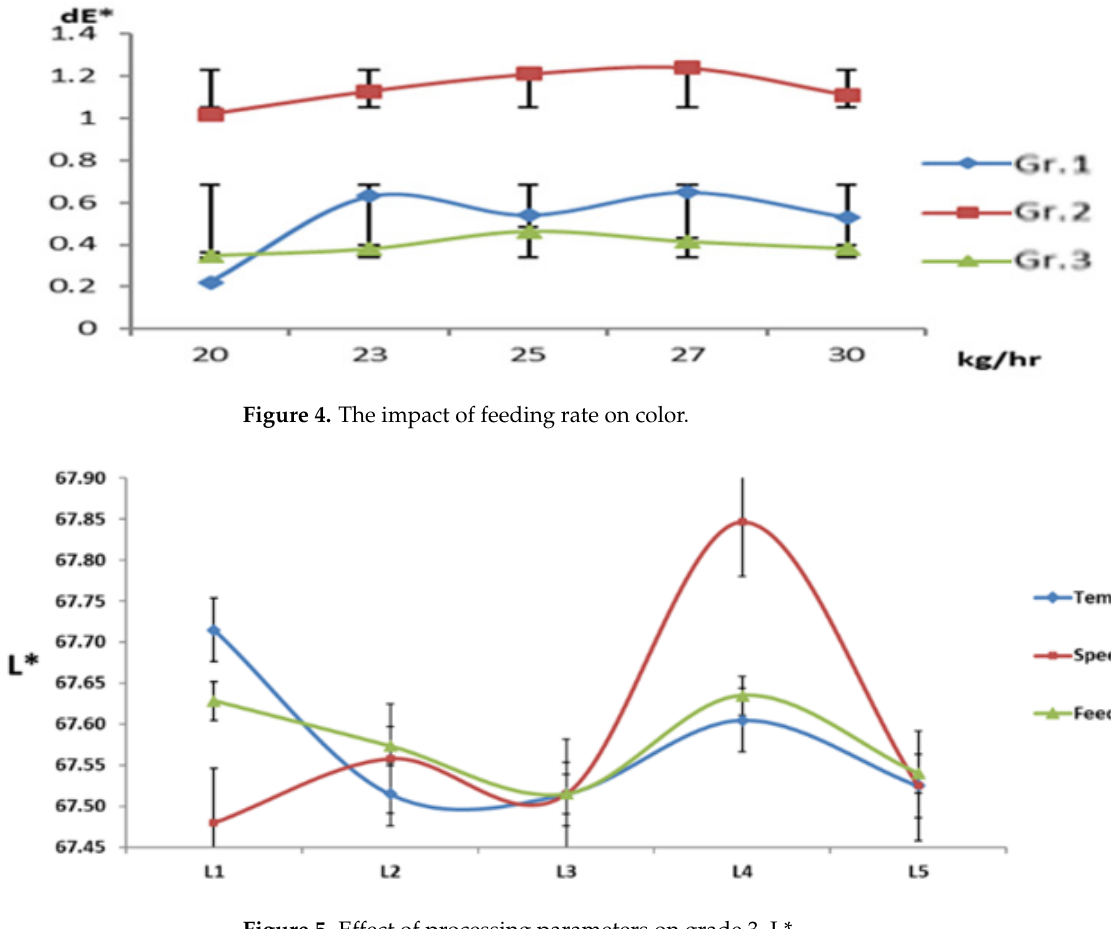
Figure 5. Effect of processing parameters on grade 3, L*.